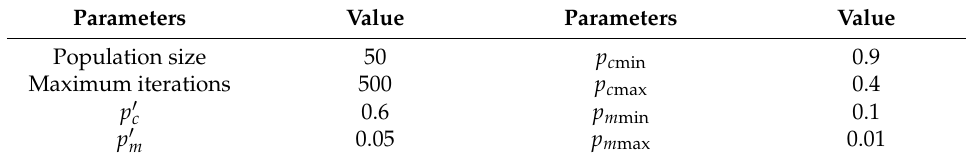
Table 4. Parameters of SCGA.